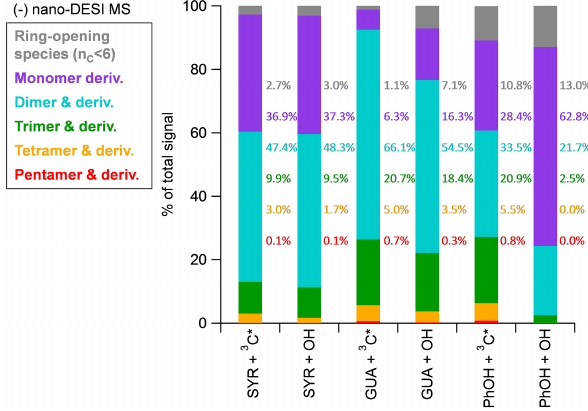
Figure 4. Contributions of reactants (phenolic precursor and DMB) and products (dissolved volatile species and aqSOA) to the solution TOC after illumination to t 1 / 2 . TOC amounts are expressed relative to the TOC in the initial solution prior to illumination (i.e., at t 0 ).